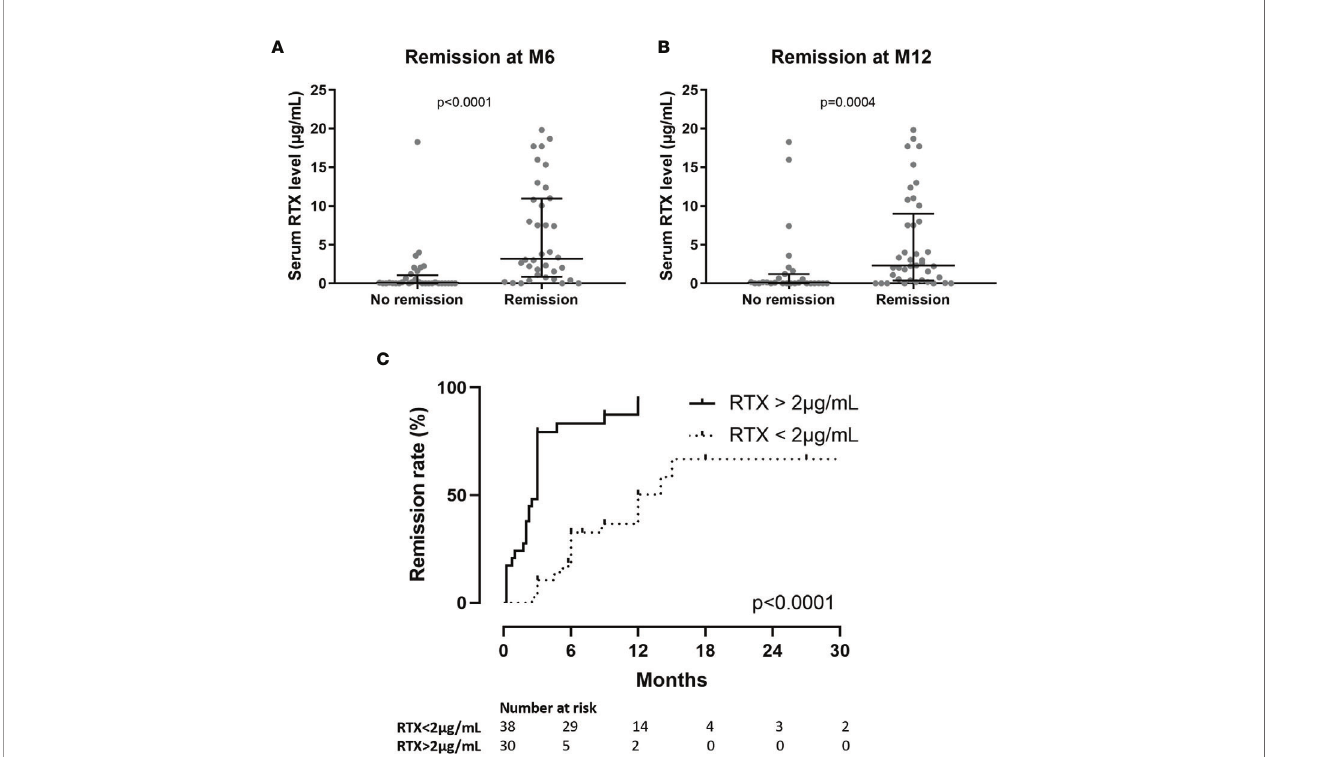
FIGURE 1 | (A) Serum rituximab (RTX) levels at month-3 (M3) according to clinical statusat month-6 (M6). (B) Serum rituximab (RTX) levels at month-3 (M3) accordingto clinical statusat month-12 (M12). (C) Time from initiation ofrituximab treatment to remission ofnephroticsyndrome according to serum rituximab levelsat month-3. M3, month-3 after rituximab injection;M6, month-6 after rituximab injection;M12, month-12 after rituximabinjection; RTX, rituximab; UP, 24-hour urinary protein excretion.